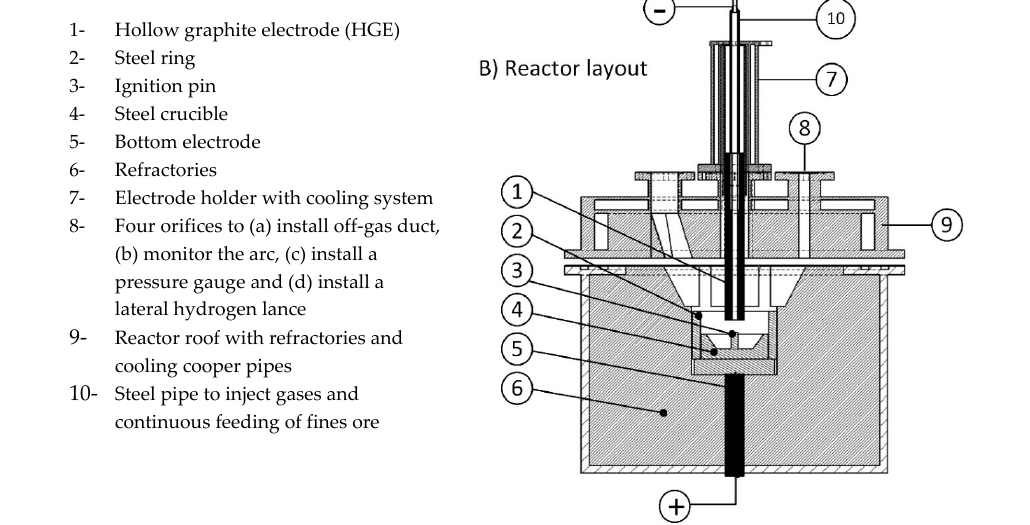
Figure 2. Drawing of the steel crucible, dimensions are in mm.